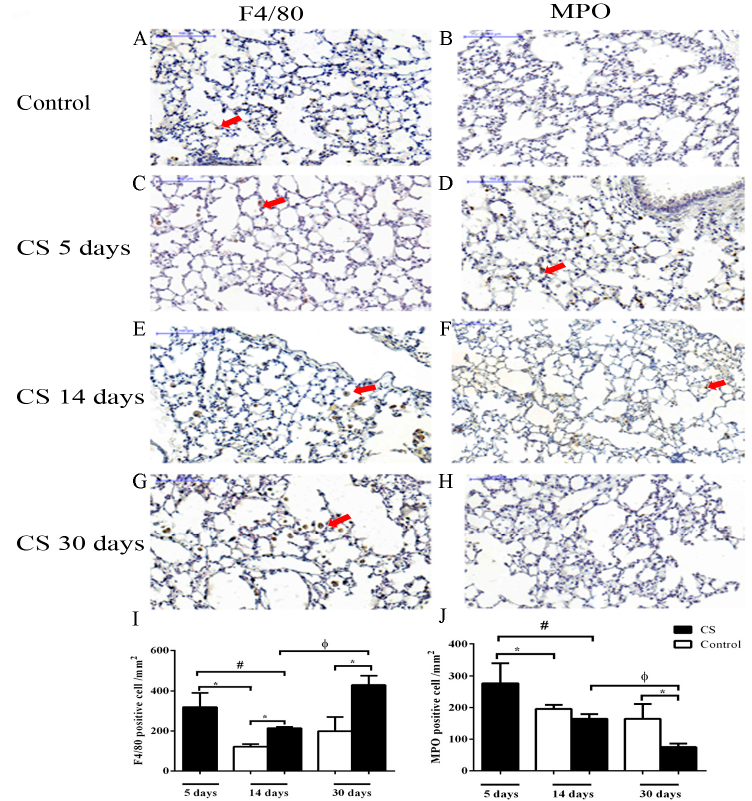
Figure 2. Effects of CS in cell populations in lung tissue. Mice were exposed to ambient air 14 and 30 days ( A and B ) or CS for 5 days ( C and D ), 14 days ( E and F ) and 30 days ( G and H ). Myeloperoxidase (MPO) expression was used as a neutrophil marker and F4/80 was used as a macrophage marker. Arrowheads represent positive cells. Bars are equal to 100 μ m. * p < 0.05 when compared to control; # p < 0.05 compared to CS 5 days group; ϕ p < 0.05 compared to CS 14 days group. The values for all the measurements are expressed as the means ± SEM for 7–11 mice per group. All statistical analyses were performed with a one-way analysis of variance (ANOVA), followed by a Tukey’s post hoc